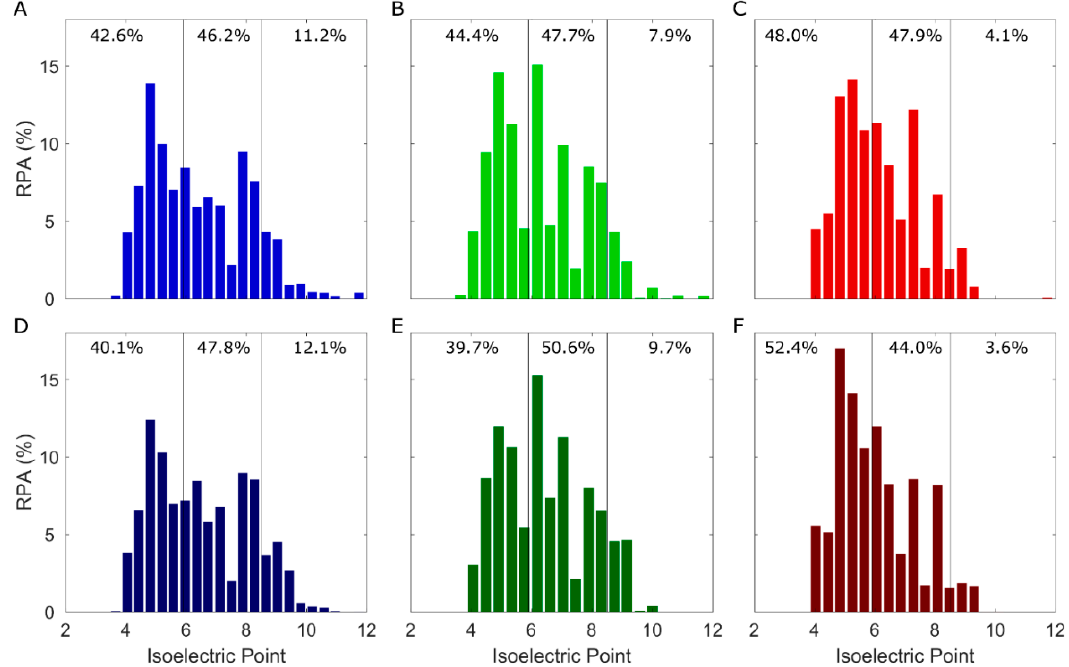
Table 2. Cumulative abundances of corona proteins with low (pI < 6), intermediate (6 < pI < 8.5) and high (pI > 8.5) isoelectric points for L1, L2, and L3. Values are reported as averages over healthy and PDAC coronas.